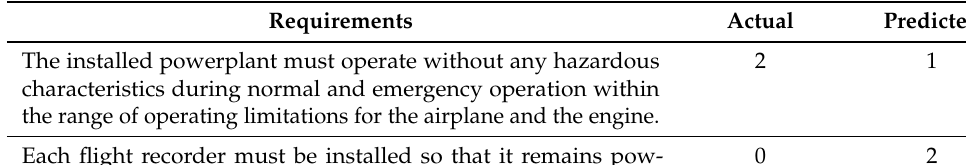
Table 10. List of requirements (from test set) that were misclassified by aeroBERT-Classifier